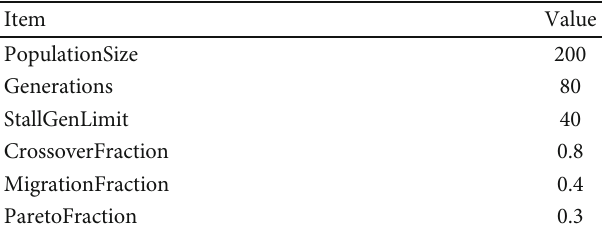
Figure 11: Training results of high neural networks. Table 8: Parameters of NSGA